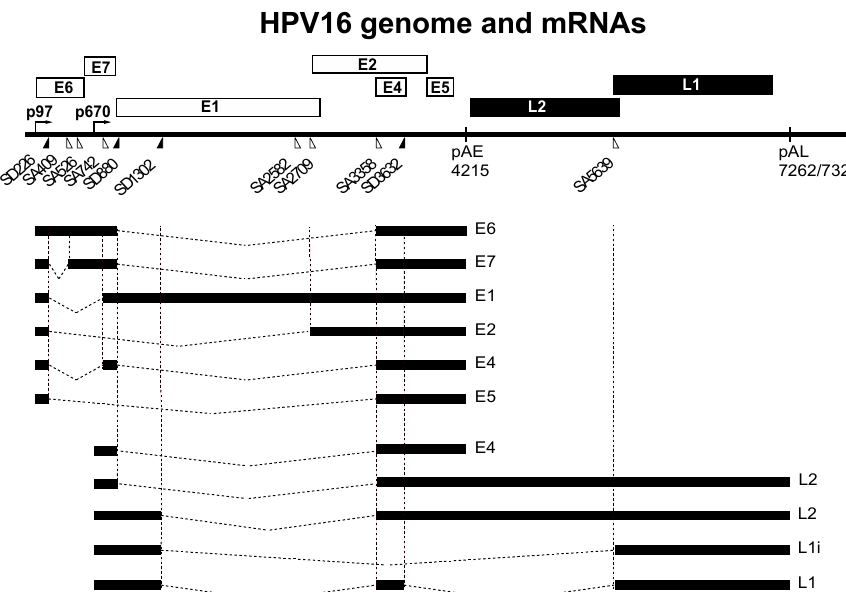
Figure 1. Schematic drawing of the human papillomavirus type 16 (HPV16) genome [3]. Boxes indicate open reading frames, filled triangles represent 5 ′ -splice sites and open triangles represent 3 ′ -splice sites. The early promoter p97 and the late promoter p670 are indicated, early and late polyadenylation signals pAE and pAL are indicated. A selection of alternatively spliced HPV16 mRNAs are shown below the HPV16 genome. L1 and L1i represent two alternatively spliced L1 mRNAs.